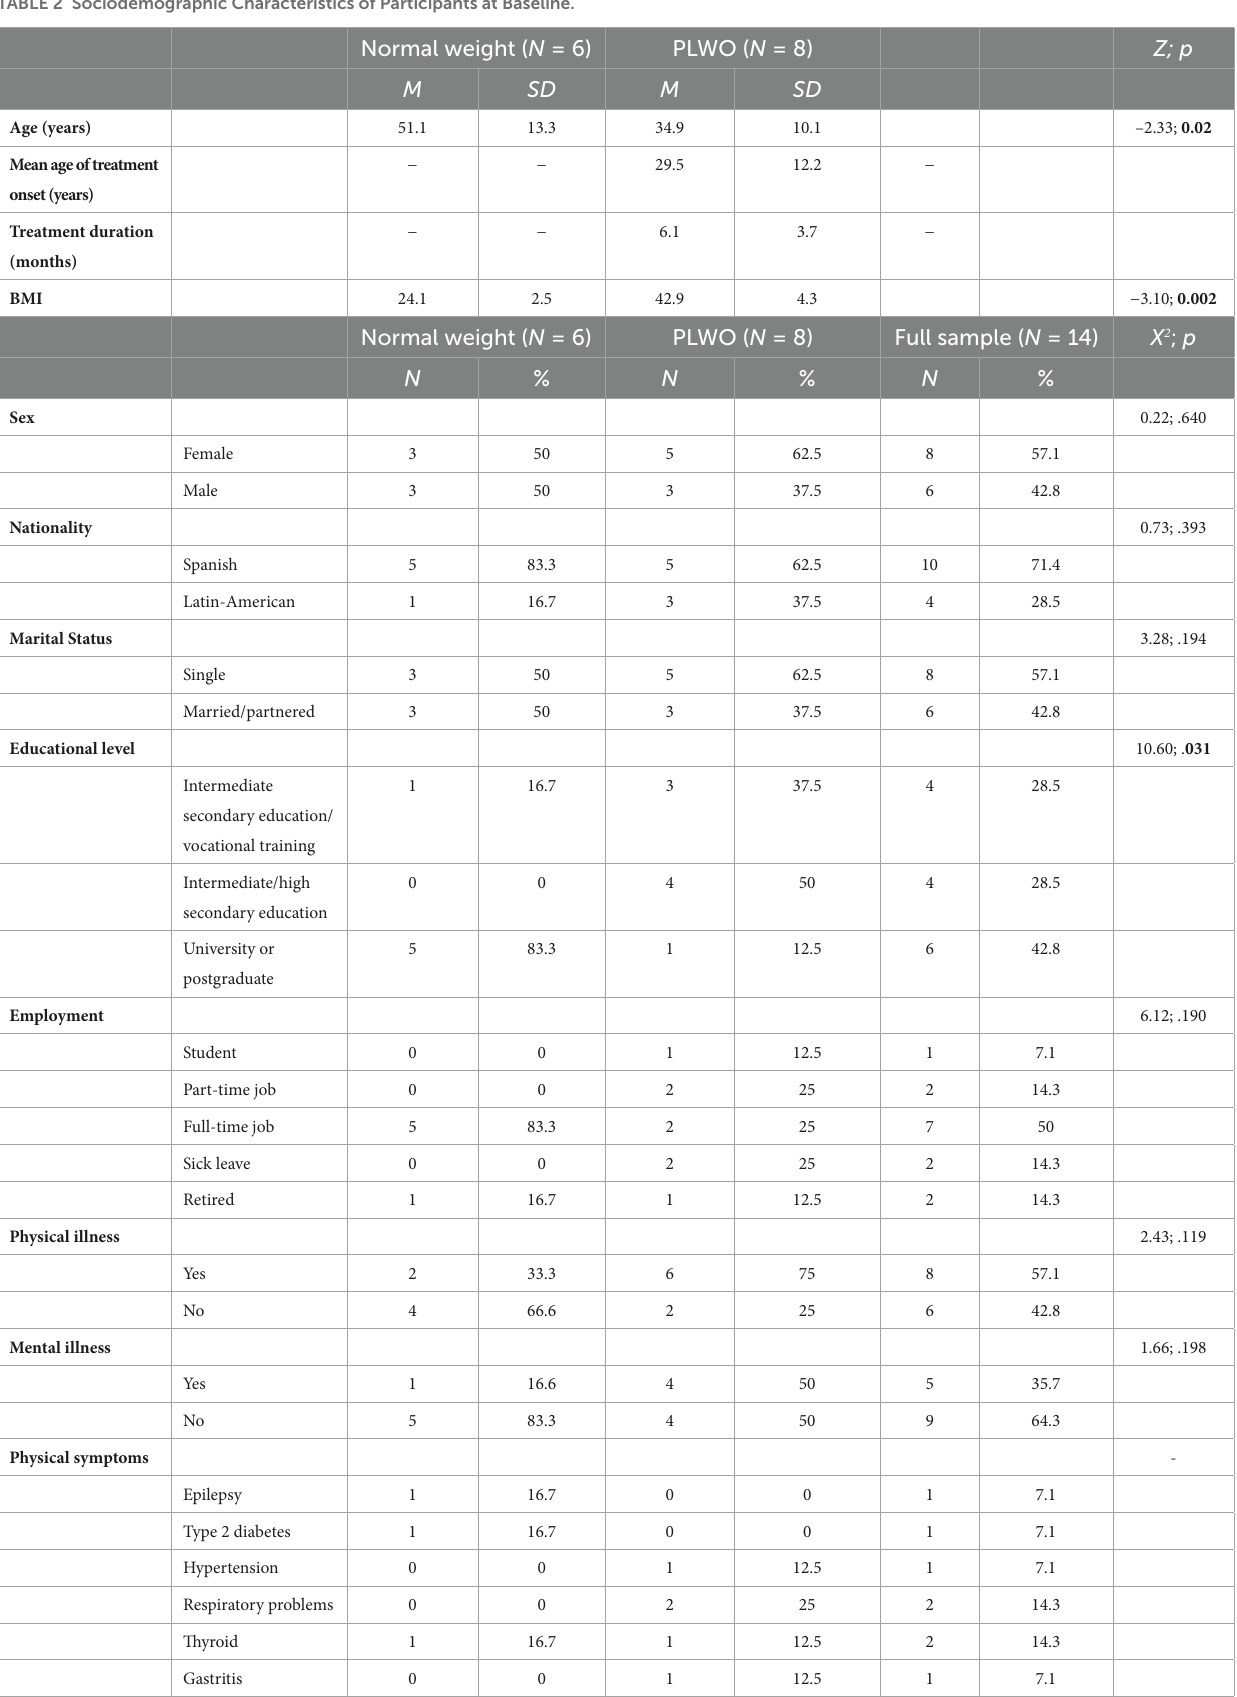
TABLE 2 Sociodemographic Characteristics of Participants at